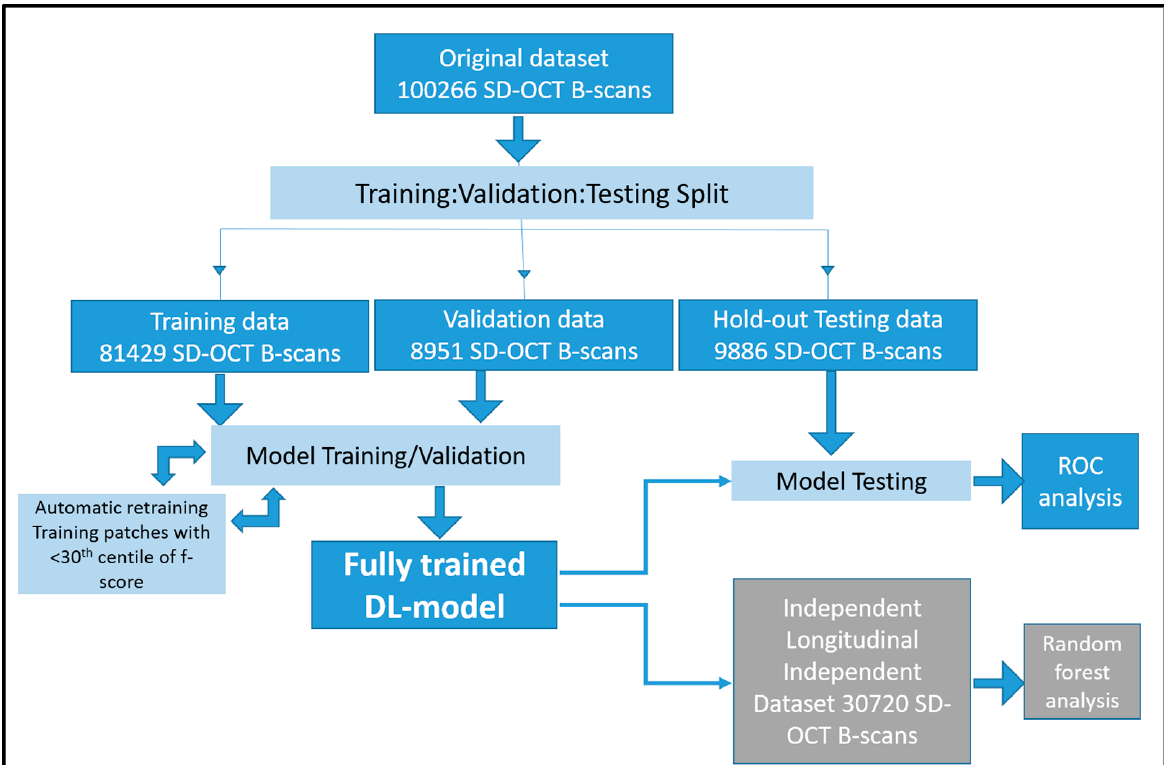
Figure 1. Flowchart of the data workflow during model training, validation, testing, and analysis. Independent random forest analysis was based on longitudinal dataset over a 5-year follow-up. The fully trained model was utilized in the DL-based measurement of percentage area of EZ At-Risk, which was subsequently tested in the random forest based predictive analysis of AMD progression.